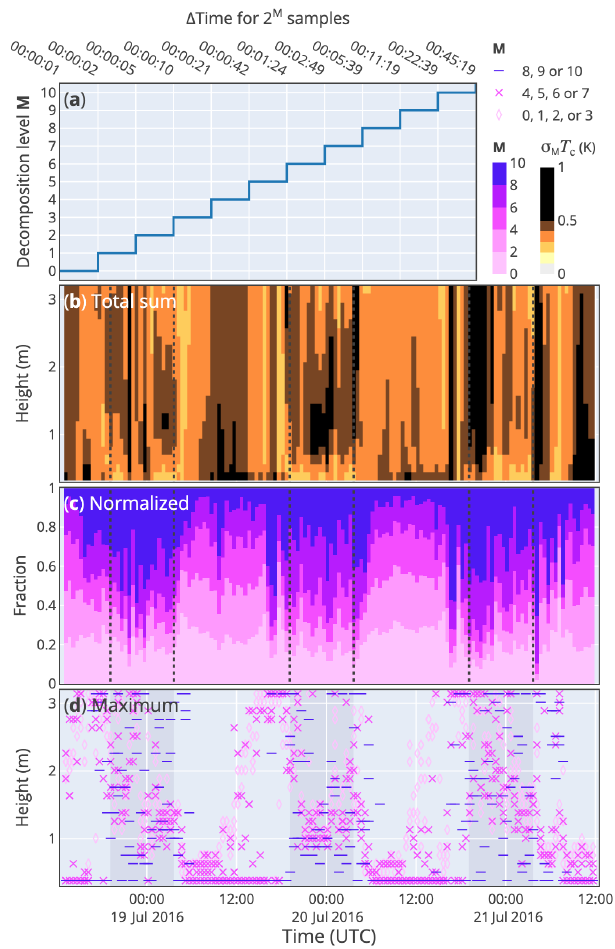
Figure 6. Shown for the MRD of T c are (a) the decomposition lev- els ( M ), and against time and height (b) the total sum of variance, σ M T c , (c) the relative contribution of each level and (d) the height of maximum mean variance for three groups of M .